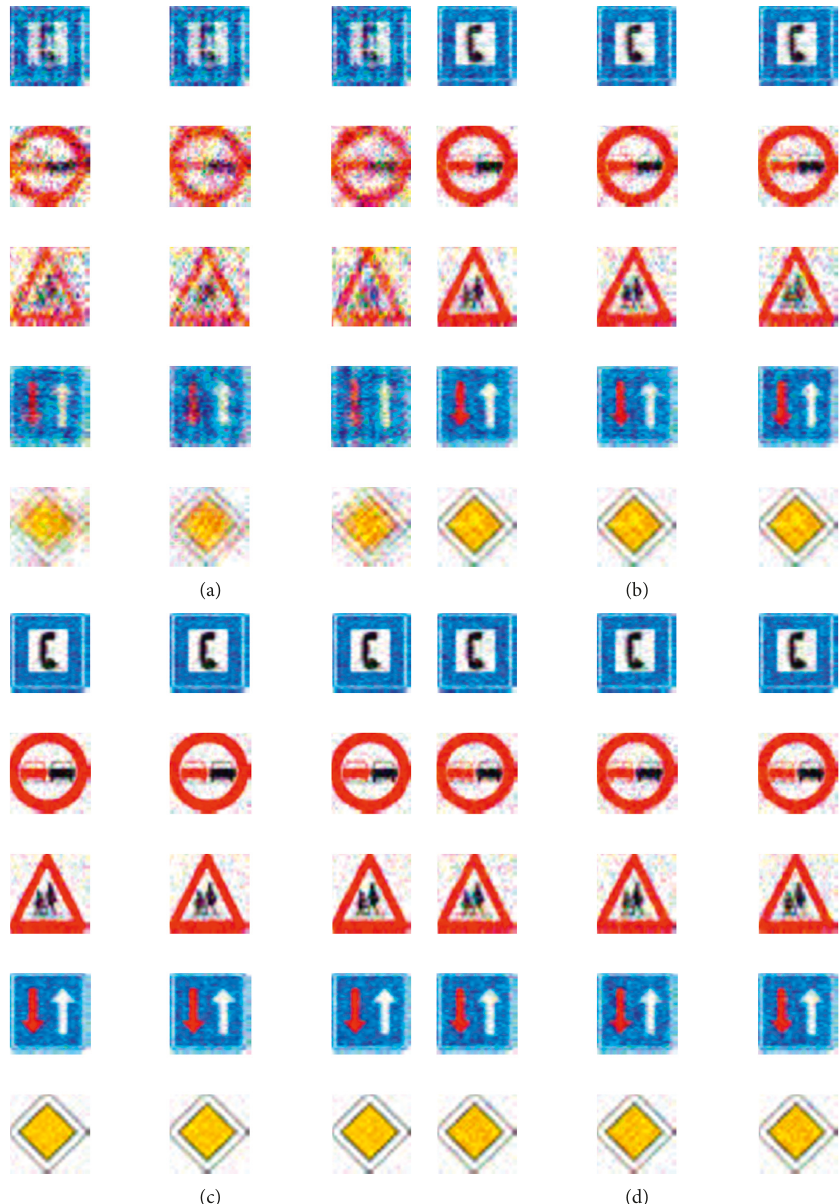
Figure 6: Illustration of the sparse recovery algorithms using different sampling rates. Reconstructed images using sparse recovery for the transmitted samples at (a) 20%, (b) 30%, (c) 40%, and (d) 50% of the original image